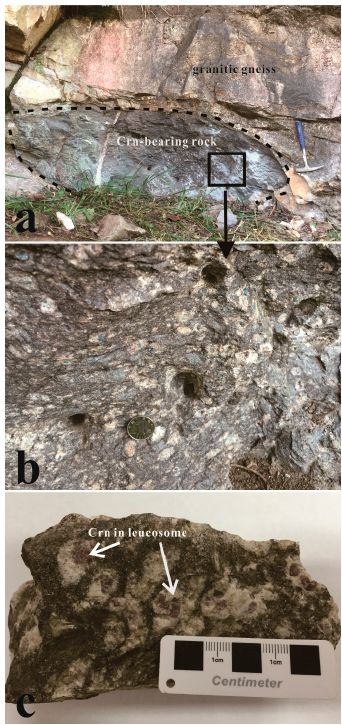
Figure 2. Field photographs of the corundum-bearing anatectic aluminous rocks exposed in the NDZ. ( a ) The boudin of corundum-bearing rocks included in the granitic gneiss (sample 1512MZT6). ( b ) Detail of the corundum-bearing rock (sample 1512MZT6). ( c ) Sample 1509GB: corundum occurs as single euhedral crystals centered in the coarse-grained leucosomes consisting of K-feldspar.